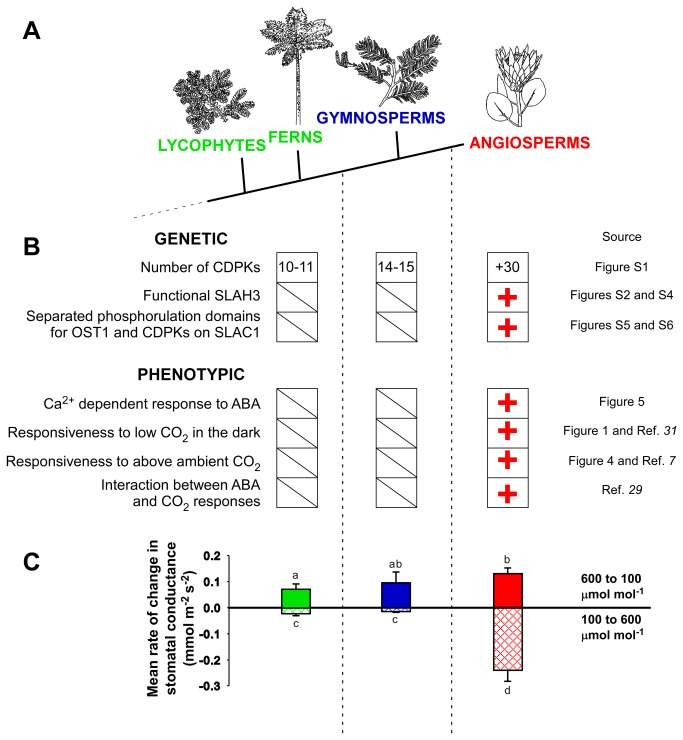
Summary of the key genetic and phenotypic characters supporting an origin of Ca2+-dependent stomatal signalling in the angiosperm clade.(A) Phylogenetic relationships between vascular plant groups, with the proposed evolution of Ca2+-dependent stomatal signalling within the angiosperm clade. (B) Results of searches (see Figures S1 and S4) for the genetic prerequisites for Ca2+-dependent stomatal signalling in the genomes of a representative gymnosperm (Picea abies) and lycophyte (Selaginella moellendorffii). As well as possessing many more CDPKs (Figure S1), angiosperms appear to have evolved several characters explicitly associated with Ca2+-dependent stomatal signalling. These innovations include a Ca2+-activated S-type anion channel (SLAH3) (Figures S2 and S4), and a dedicated CDPK phosphorylation site on the principal stomatal anion channel (SLAC1) (Figures S5 and S6). The resultant stomatal phenotype in angiosperms shows four key distinctions from other vascular plants in the stomatal response to CO2. (C) Faster dynamic stomatal closure in response to a step rise in ambient CO2 was observed in our angiosperm sample group (n= 11, ±SE) compared with combined lycophytes and ferns (n=12, ±SE) and gymnosperms (n=10, ±SE), this was unlike statistically similar rates of stomatal opening across groups following a step drop in ambient CO2, different letters denote significant difference (P<0.05). This suggests that Ca2+-dependent stomatal signalling provides angiosperms with an adaptive advantage by allowing faster dynamic stomatal closure in response to changing leaf internal CO2, thereby enabling more efficient use of water.